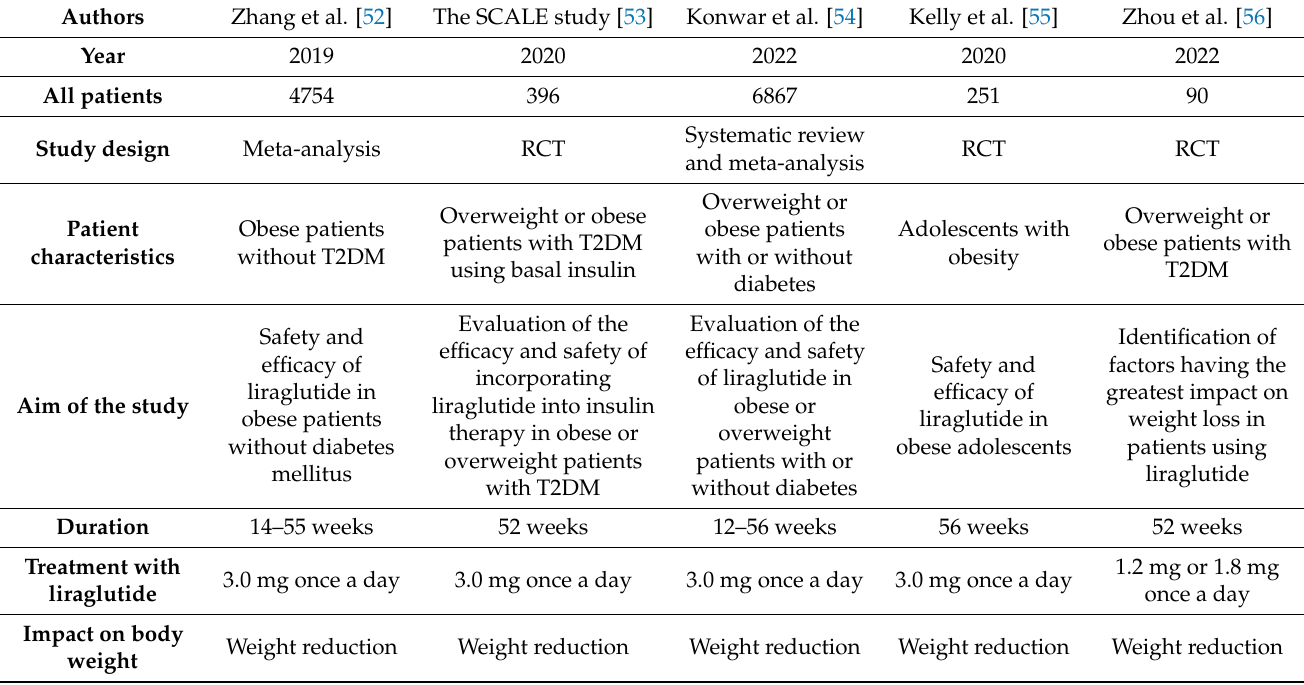
Table 7. Comparison of studies on the effect of liraglutide treatment on weight reduction